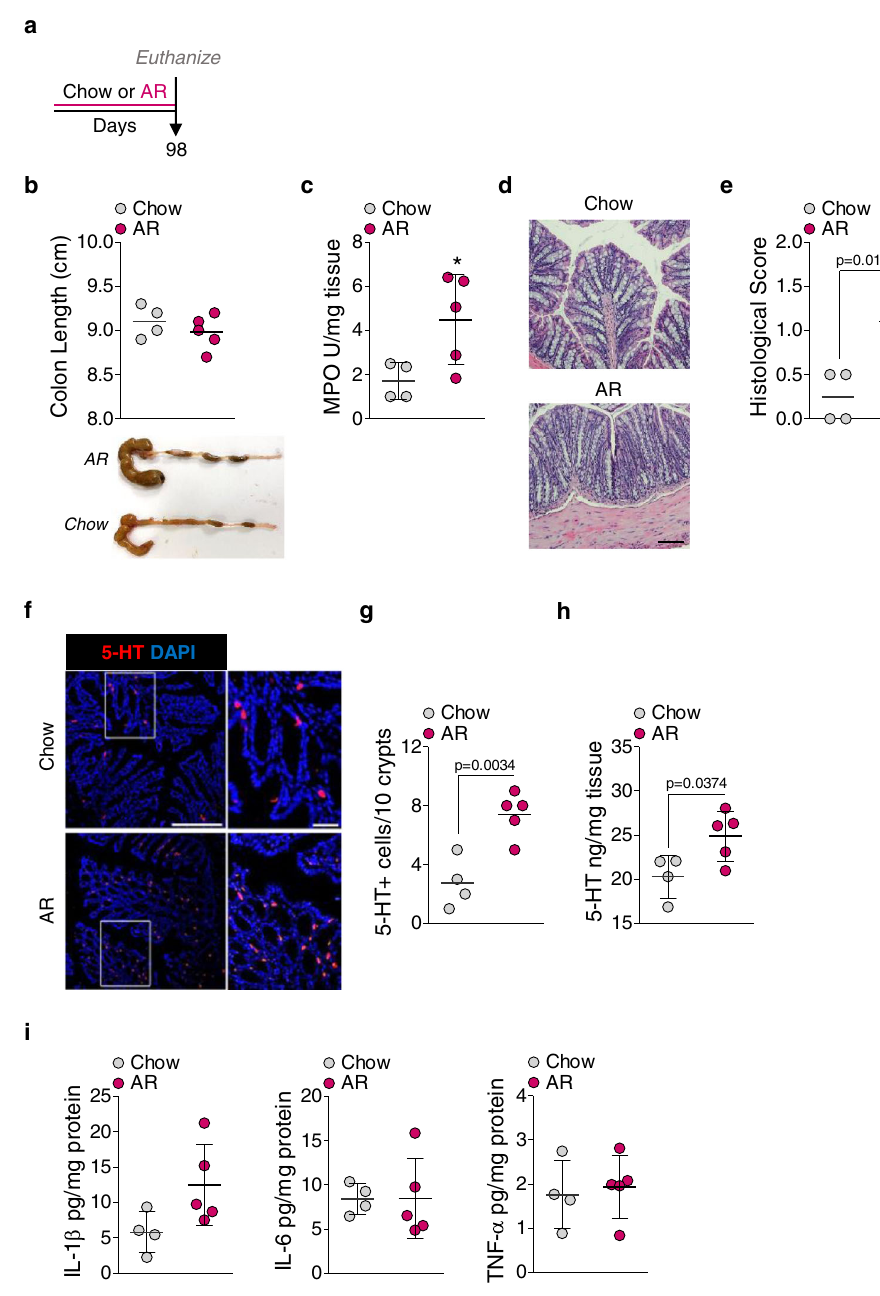
Fig. 7 | AR increases colonic 5-HT levels in the absence of microbial signals. GF mice were either fed normal chow diet or exposed to 100ppm AR via diet for 14 weeks (98 days). a Schematic illustration of the experimental design. b Colon length (cm). A representative image of colons. c Colonic MPO levels. d Representative images of H&E-stained colon sections; scale bar: 100 μ m. e Histological score. f Representative images of IF staining for 5-HT (red)